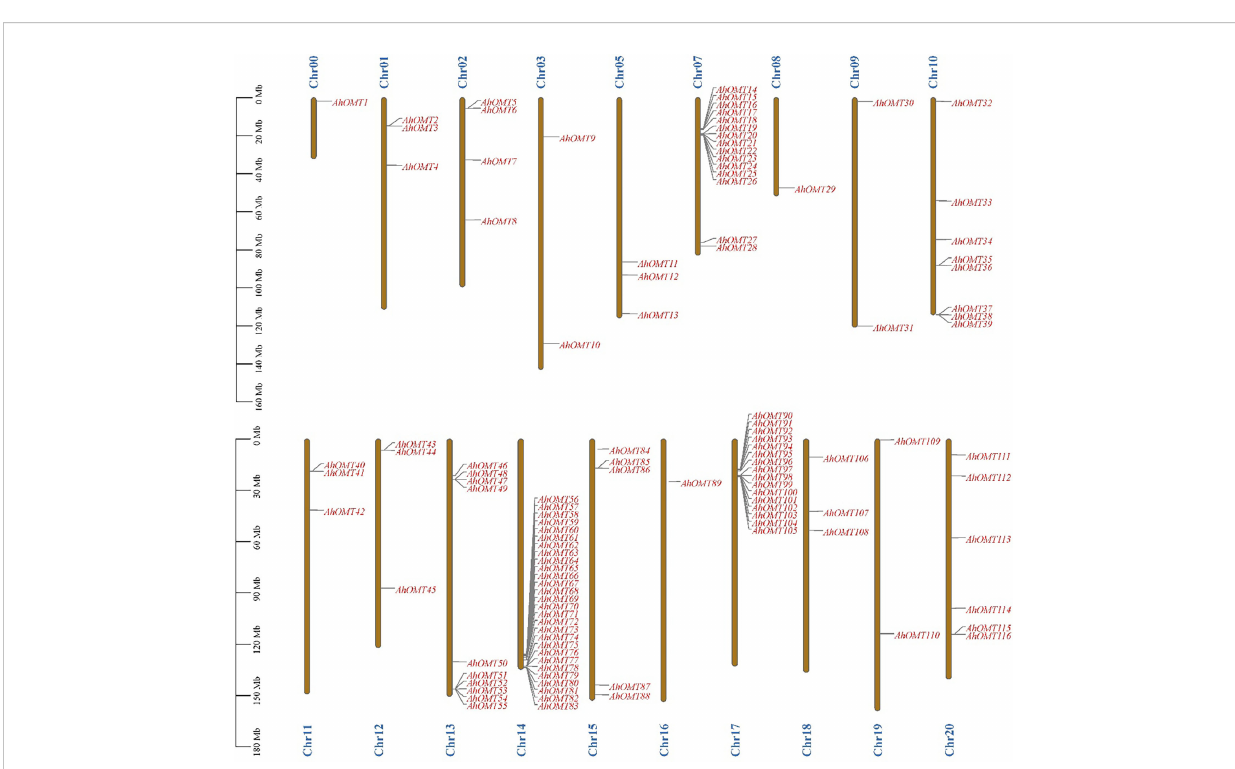
species are present in all clades. Group one is the smallest group as compared to other groups.